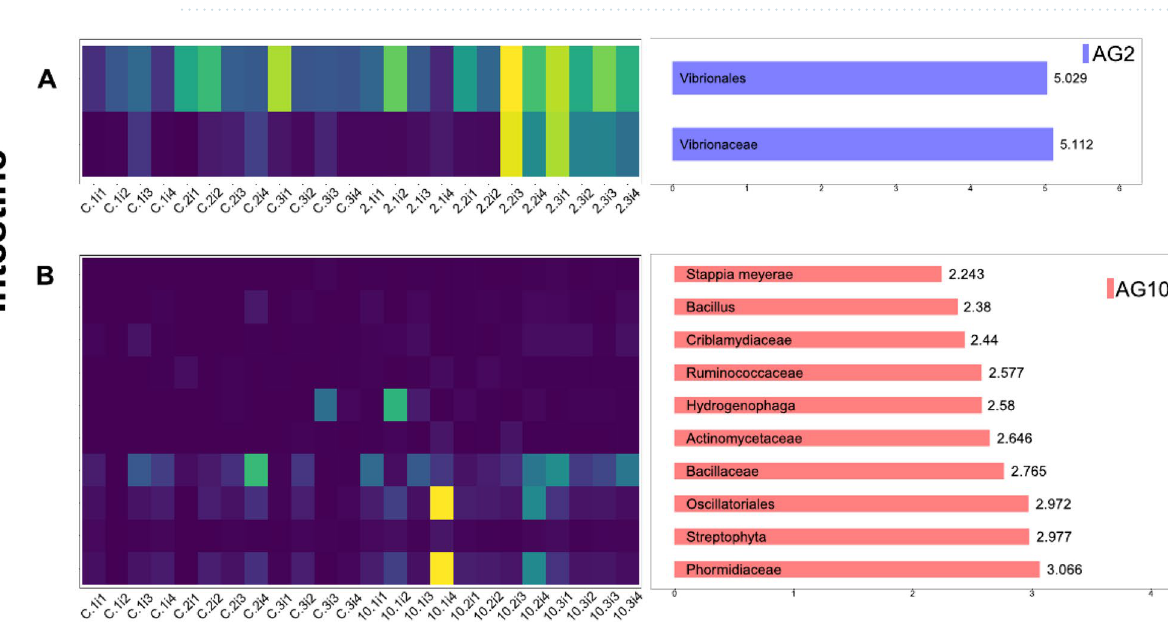
Figure 5. Heatmap of LEfSE results of enriched taxonomic groups in intestines and their abundance distribution per sample by agavin treatment. ( A ) A2 diet and ( B ) A10 diet. Bar plots represent the log10 LDA score for each classification. Only the top 10 taxonomic levels bearing informative taxonomic labels and LDA effect size > 2(log10) scale are shown. The heatmap shows the abundance of those taxa in the samples with more abundant taxa in